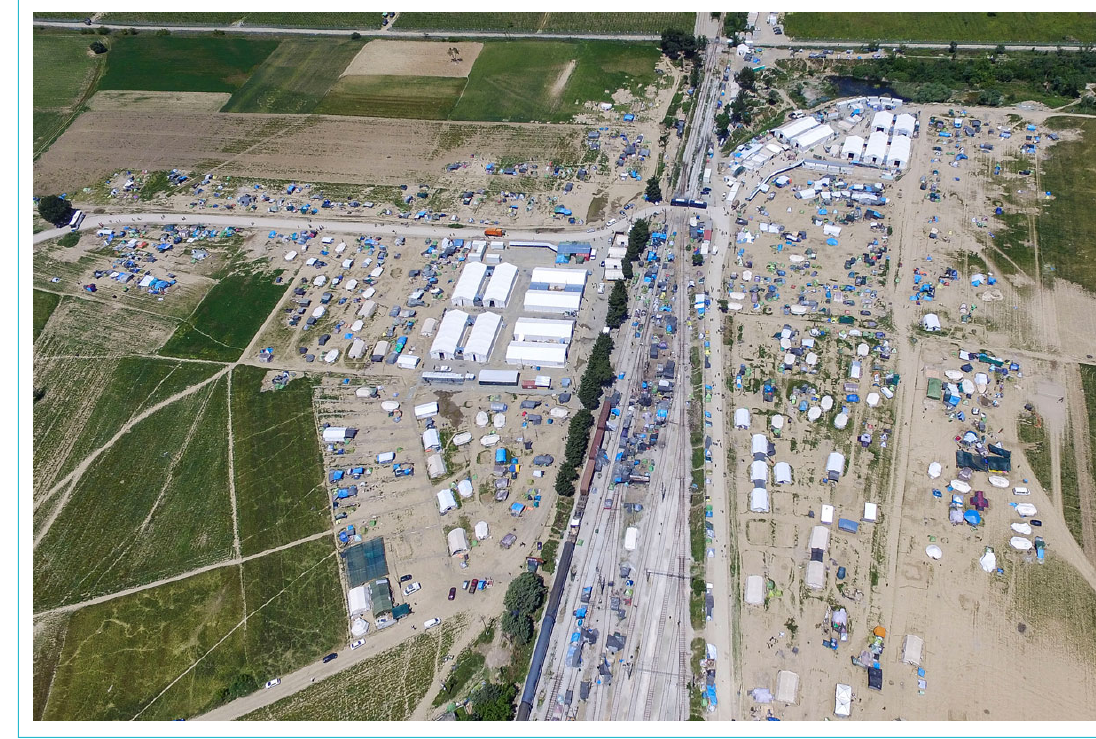
Figure 3: Mapping the refugee camp of Idomeni in northern Greece, 2017. © Nicolas